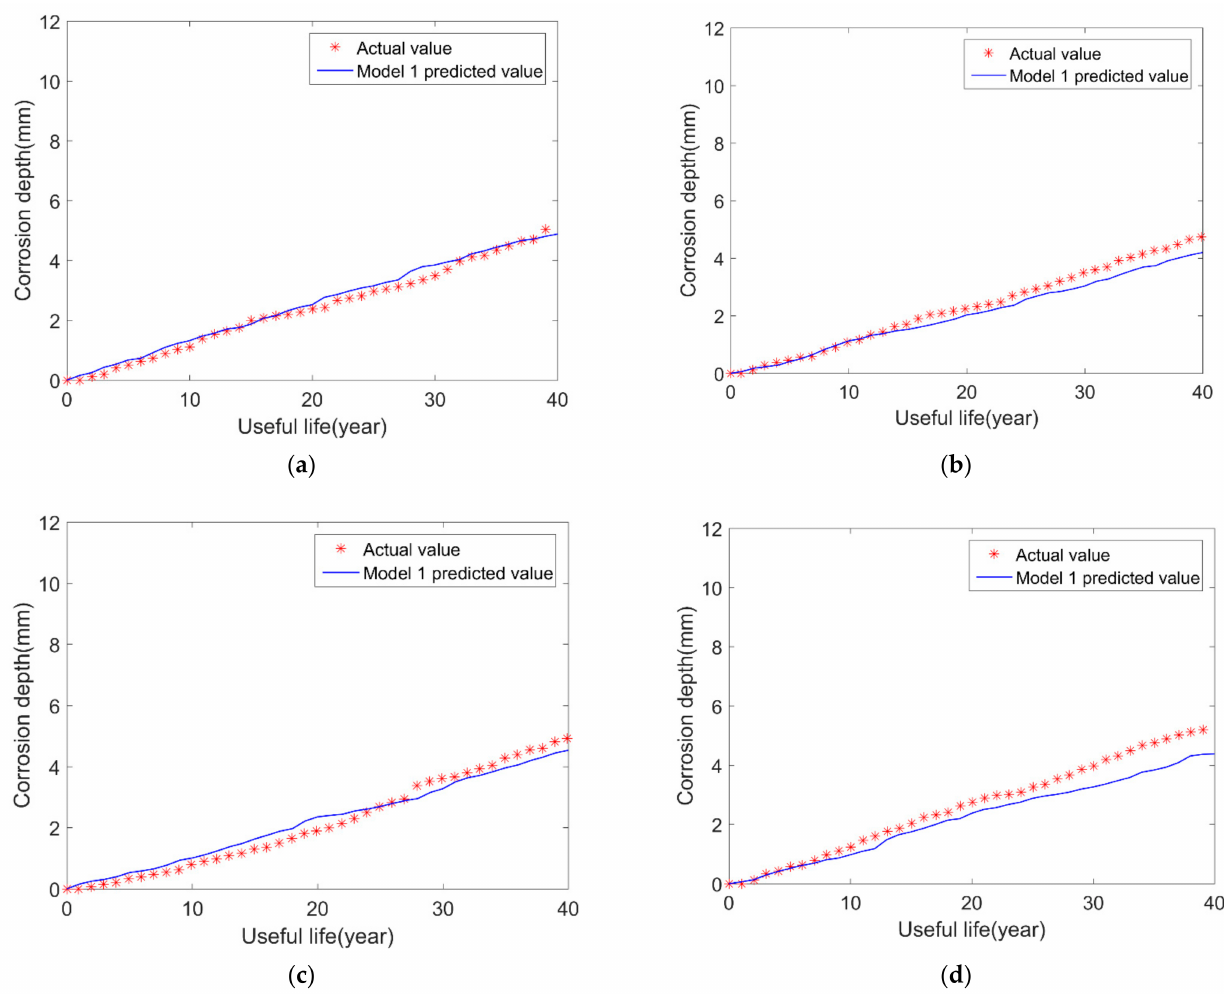
Figure 8. Comparison results of model 1 and the real results: ( a ) sample 1; ( b ) sample 2; ( c ) sample 3; ( d ) sample